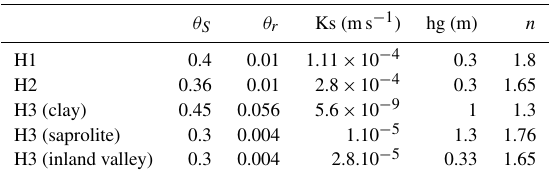
Table 3. Hydrodynamic properties for the virtual V-shaped catch- ment, following Van Genuchten